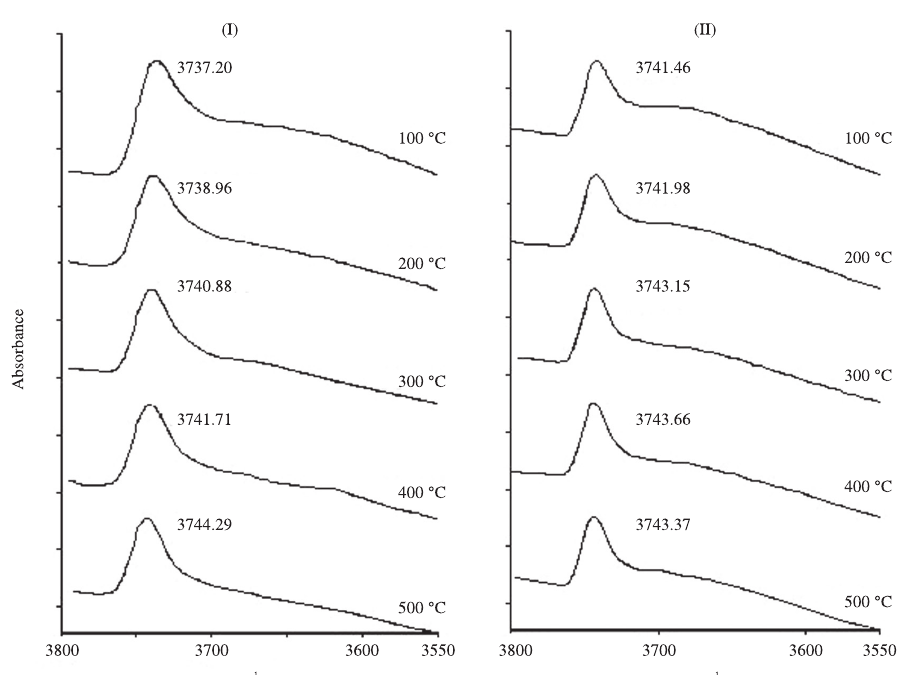
Figure 7. Behavior of FTIR spectra of the OH-stretching region, with the increase of pyridine desorption temperature of zeolite samples I) HT760 and II) HT960.